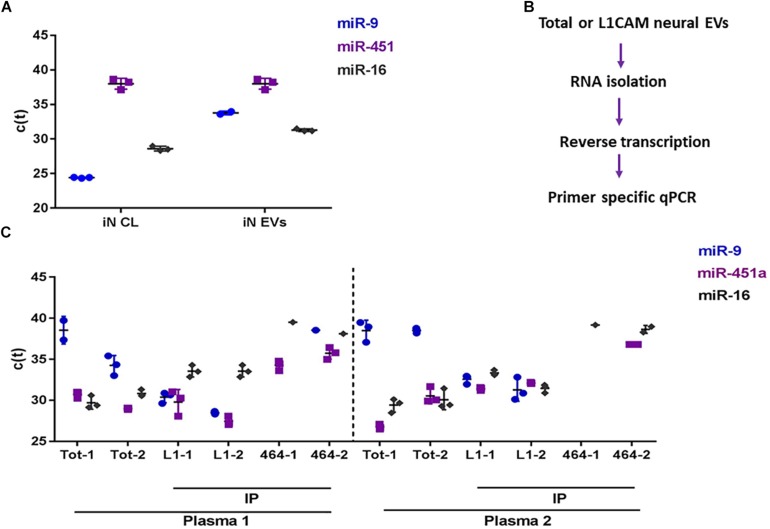
miRNA analysis of brain-derived exosomes in blood. (A) C(t) values for neuron-specific miR-9, plasma abundant miR-451a, and ubiquitously expressed miR-16 from induced neuronal (iNs) cell lysates (CL), and iN exosomes isolated by ultracentrifugation of iN conditioned medium. (B) Flow chart for the detection of miRNAs from plasma exosomes. RNAs were isolated from total plasma exosomes (Exoquick pellets), or neural exosomes immunoprecipitated (IP) from total plasma exosomes with anti-L1CAM antibody. RNA was reverse transcribed with Qiagen’s HiFlex buffer to generate cDNAs, and subsequently used as template for qPCR using miRNA-specific primers for miRNA detection. C(t) values for miR-9, miR-451a, and miR-16 from (C) plasma-derived total- and L1CAM (L1)- immunoprecipitated exosomes. As a negative control, an irrelevant antibody, 46-4 was used for immunoisolation. Total and IP’ed exosomes were isolated in duplicate (#1 and #2) from 2 healthy control donors (Plasma 1 and plasma 2). Low Ct values indicate high levels of miRNA, and high Ct values indicate low levels of miRNA. The reliable CT limit is ∼40.